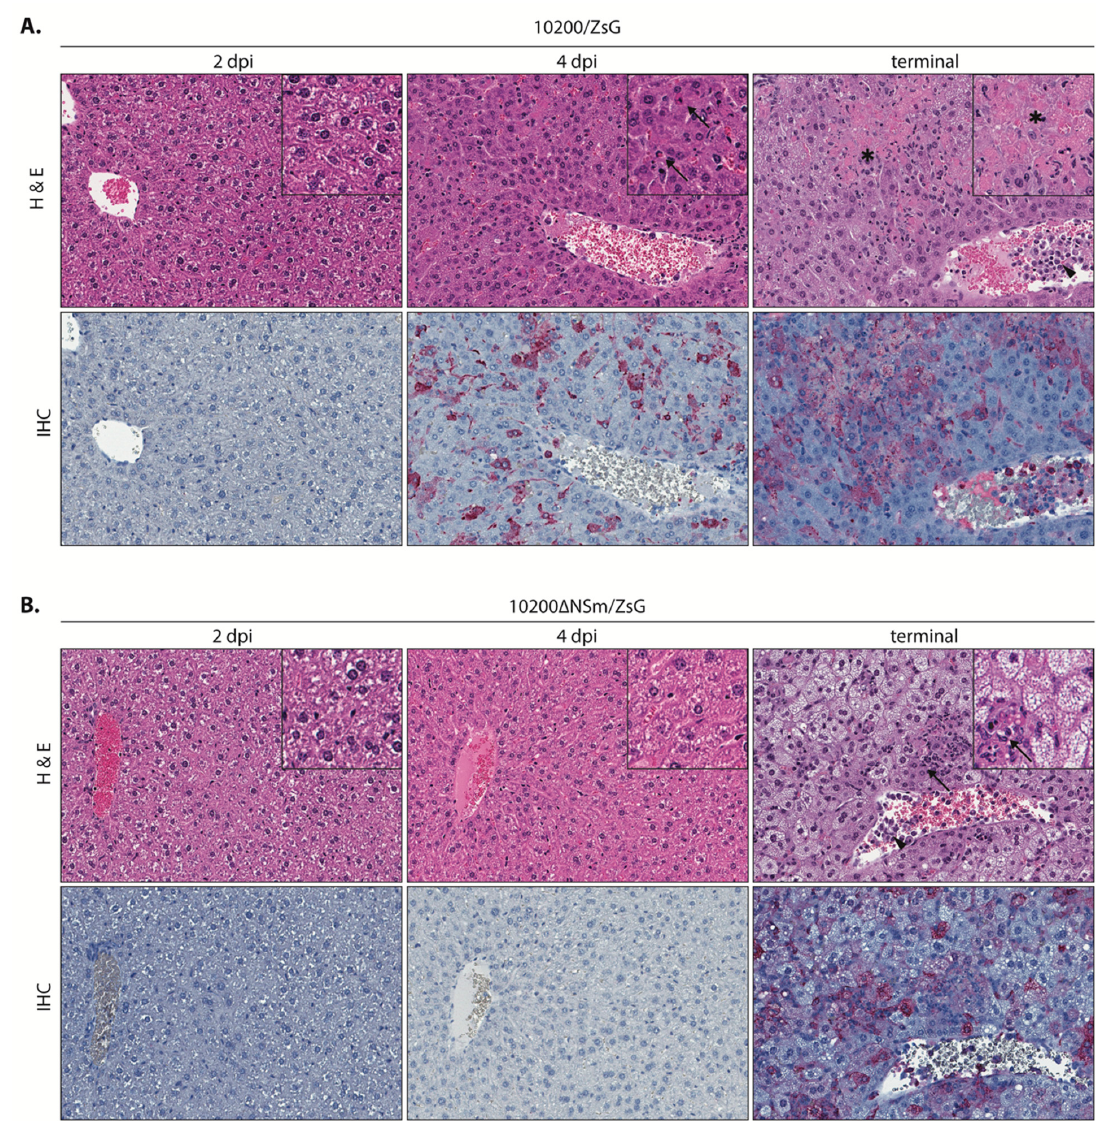
Figure 5. Liver pathology and CCHFV antigen distribution visualized by immunohistochemistry in Ifnar − / − mice infected with 10200/ZsG or 10200 Δ NSm/ZsG. ( A ) Mice infected with 10200/ZsG displayed no pathology or CCHFV immunostaining 2 dpi (left panel). At 4 dpi, 1 of 3 animals had scattered, mostly single-cell hepatocyte necrosis (arrow) with immunostaining (red) of hepatocytes and Kupffer cells (middle panel). All terminal animals (euthanized 5–6 dpi) had widespread regions of confluent hepatocyte necrosis (*) and immunostaining. Increased numbers of intravascular leukocytes (arrowhead) with immunostaining were also seen (right panel). ( B ) Histopathologic evidence of liver damage and immunostaining was delayed in 10200 Δ NSm/ZsG-infected mice, with no pathology or CCHFV immunostaining detected 2 dpi or 4 dpi (left and middle panels). In terminal 10200 Δ NSm/ZsG animals that succumbed to infection (7–9 dpi), extensive but sublethal hepatocyte injury was characterized by diffuse hepatocyte swelling and vacuolation and was accompanied by scattered necrosis and neutrophilic inflammation (arrows). Increased intravascular leukocytes (arrowhead) and immunohistochemical staining patterns (red) were similar to those seen in terminal 10200/ZsG animals. Top row: hematoxylin-eosin; original magnification: 200× (inset 400×). Bottom row: CCHFV immunoalkaline phosphatase staining with naphthol fast red substrate, hematoxylin counterstain; original magnification: 200×.